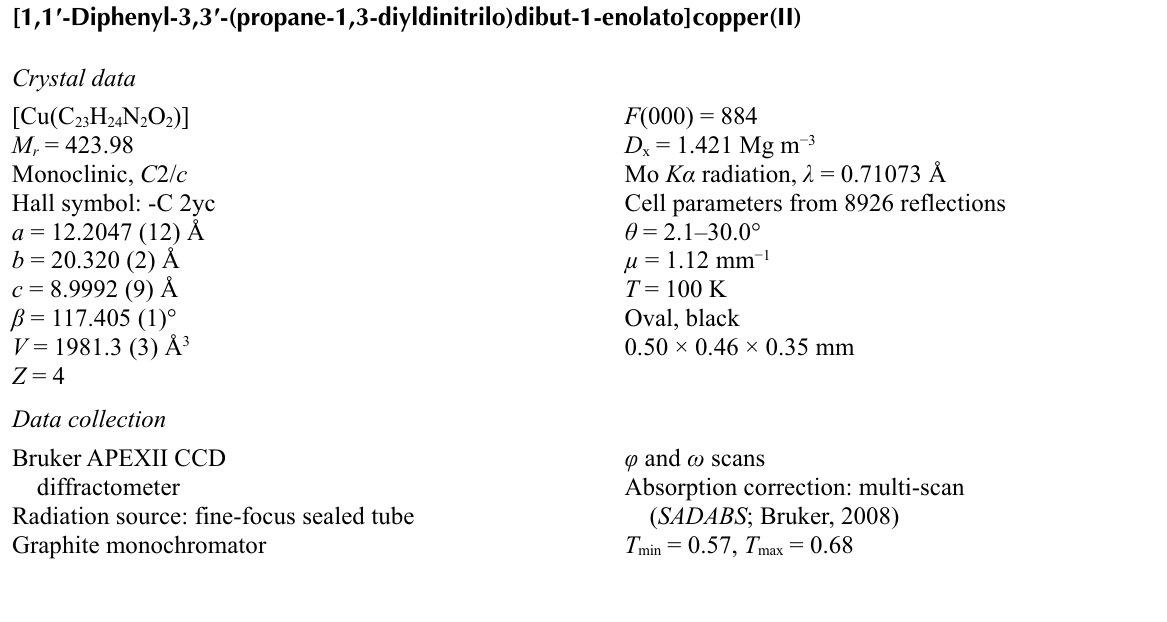
The ORTEP drawing of (I), with atom labeling scheme. Displacement ellipsoids are drawn at the 50% probability level. [Symmetry code: (A) 1-x, y,